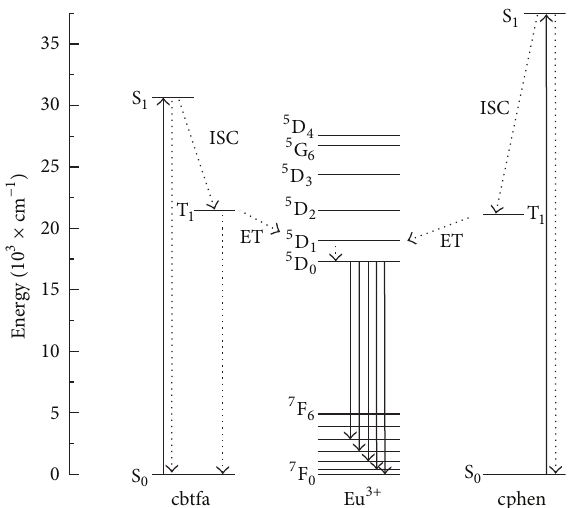
Figure 7: Scheme of the energy transfer mechanism and emission process. The singlet and triplet values of Hcbtfa have been estimated from those reported for Hbtfa [16, 45]. The singlet and triplet values for 5-chloro-1,10-phenanthroline have been taken from [46]. ISC and ET stand for intersystem crossing and energy transfer,